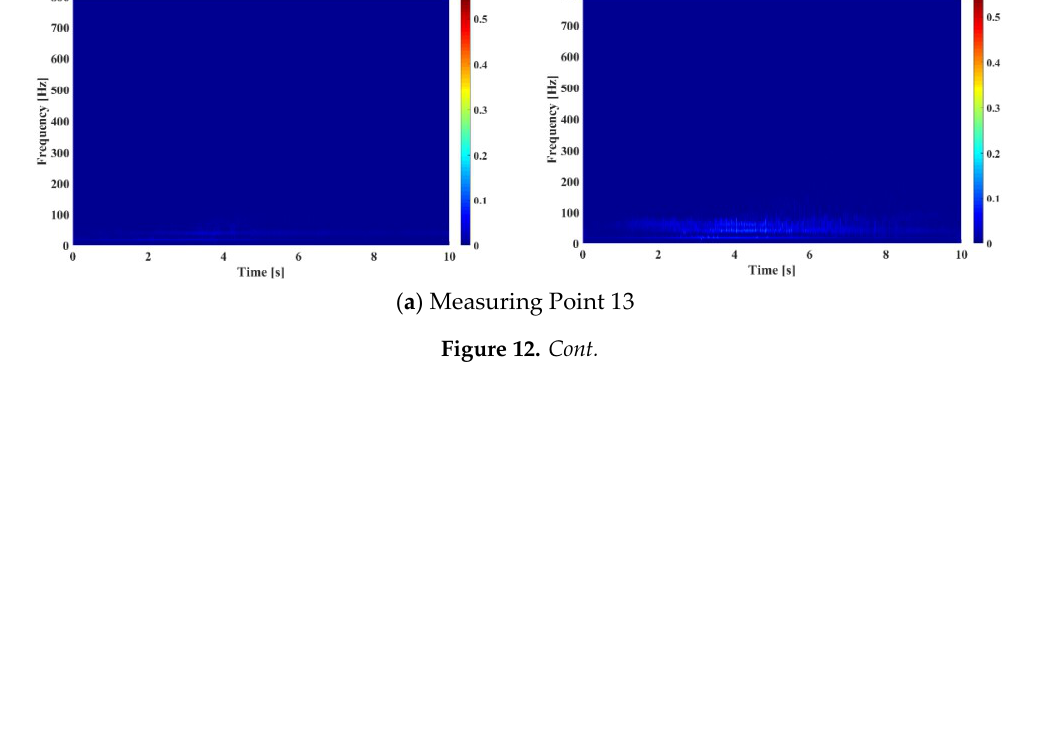
Figure 11. Intrinsic Modal Function (IMF) components and their Fourier spectrum s. Based on the results of EMD, the energy spectrum is obtained by Hilbert transform, and the evolution characteristics of the vibration signal energy in the time–frequency domain are represented by a two-dimensional plane contour map, and Figure 12 is the Hilbert energy spectrum